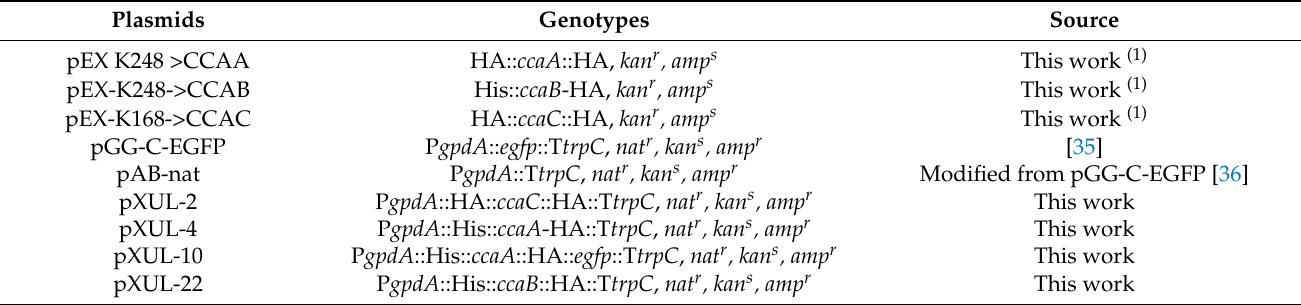
Table 2. Plasmids used in this